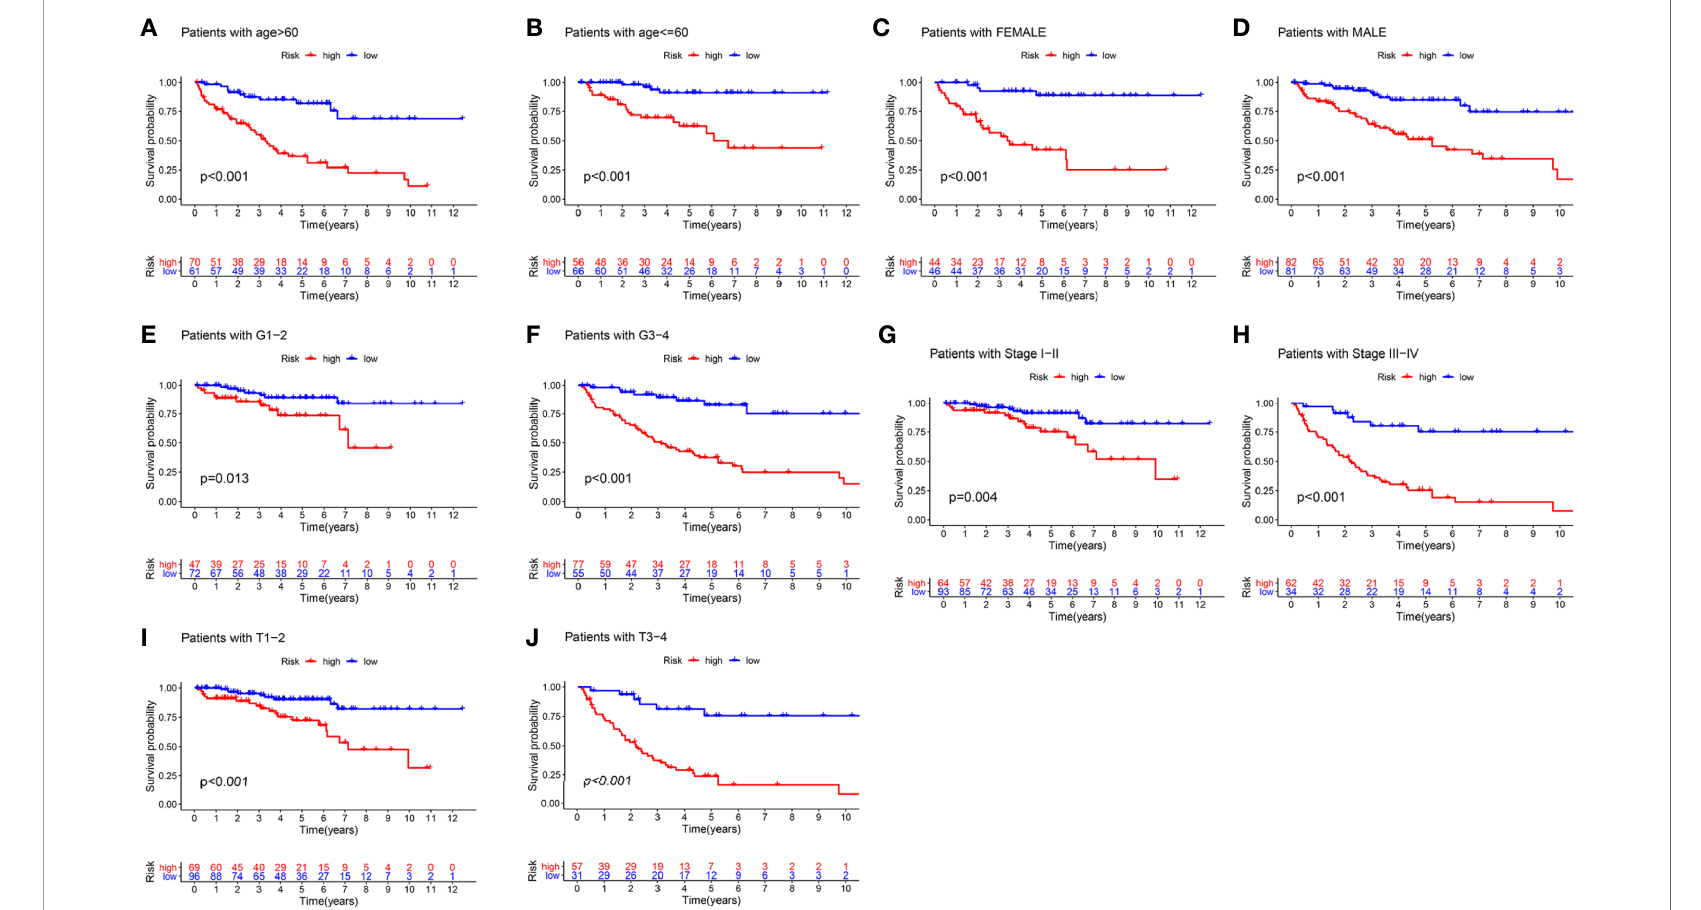
FIGURE 5 | The survival outcomes of the high- and low-risk score subgroup in KIRC patients were strati fi ed by various clinicopathological features. Kaplan-Meier survival curve showed the survival outcomes of high- and low-risk KIRC patients strati fi ed according to age (>60 years vs. ≤ 60 years) (A, B) , gender (FEMALE vs. MALE) (C, D) , AJCC grade (G1 – 2 vs. G3 – 4) (E, F) , stages (stage I – II vs. stage III – IV) (G, H) , AJCC T stage (T1 – 2 vs. T3 – 4) (I, J) , respectively (all p <